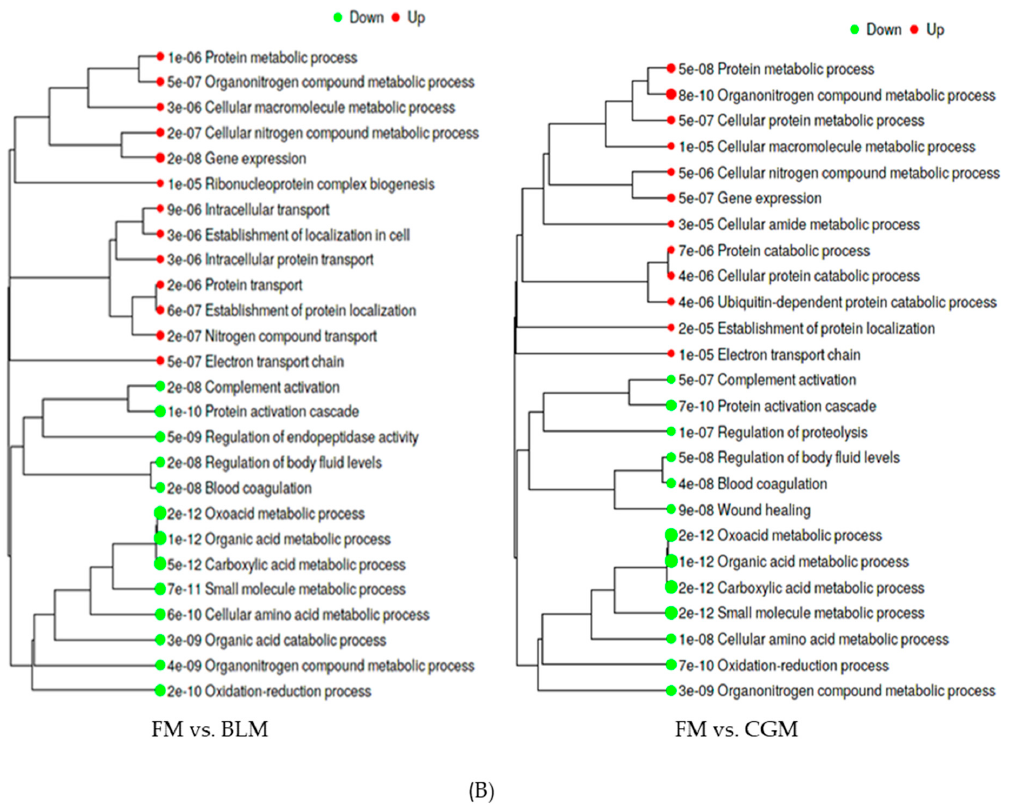
Figure 2. Enriched pathways in up and down ‐ regulated genes of the 2 comparisons: FM vs. BLM and FM vs. CGM. ( A ) heatmaps ( B ) hierarchical clustering tree. Abbreviation: FM: fish meal, BLM: blood meal, CGM: corn gluten meal. Red: up ‐ regulated pathways in FM group, Green: down ‐ regulated pathway in FM group.